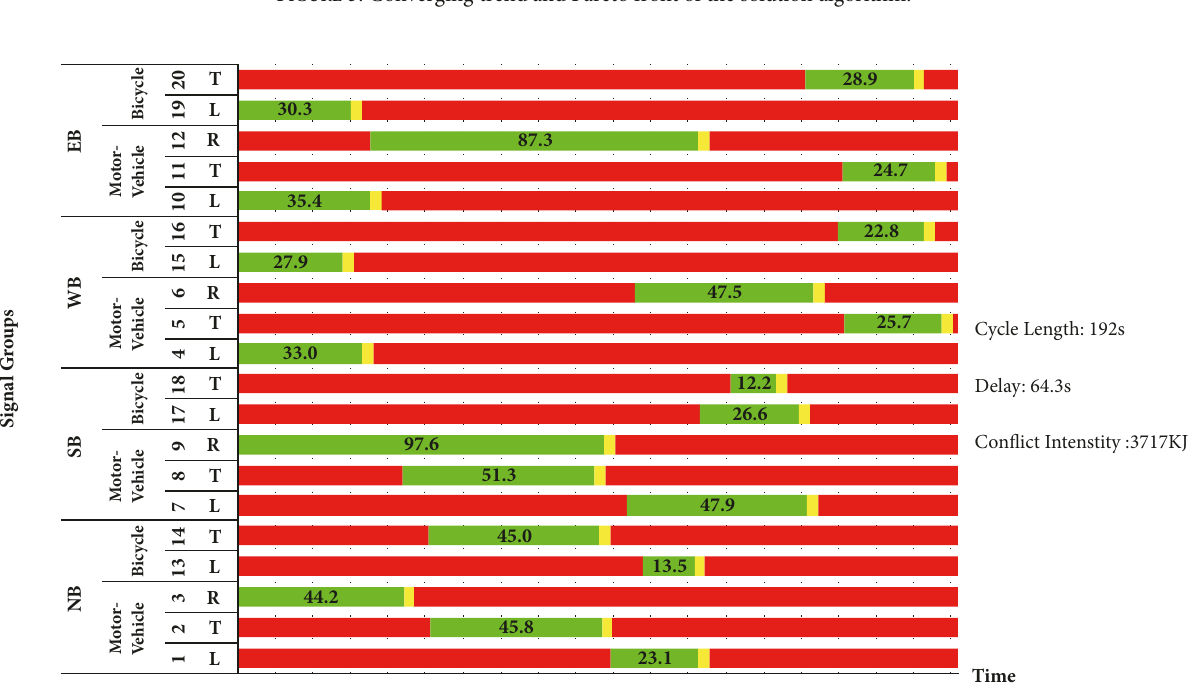
Figure 5: Converging trend and Pareto front of the solution algorithm.